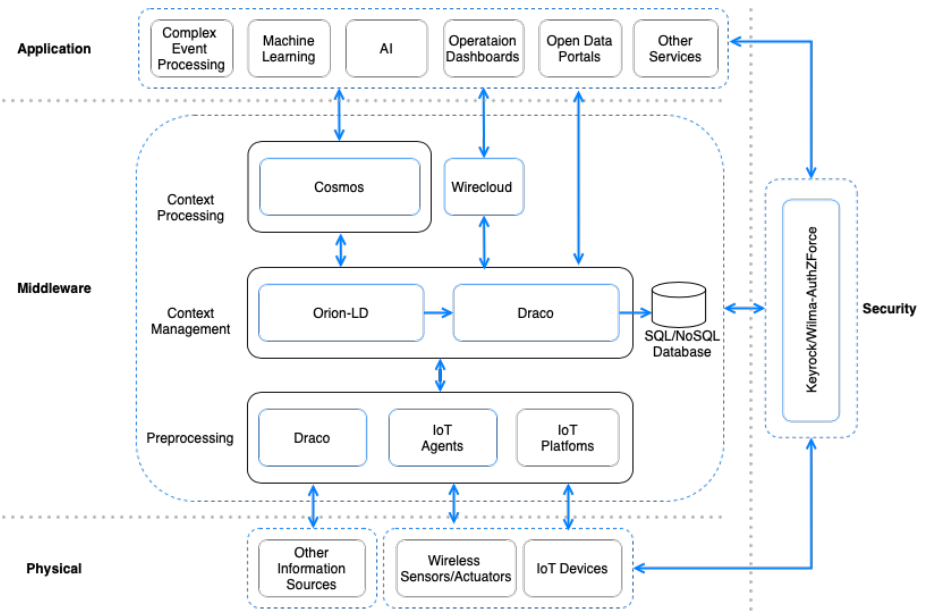
Figure 2. Reference Implementation using FIWARE